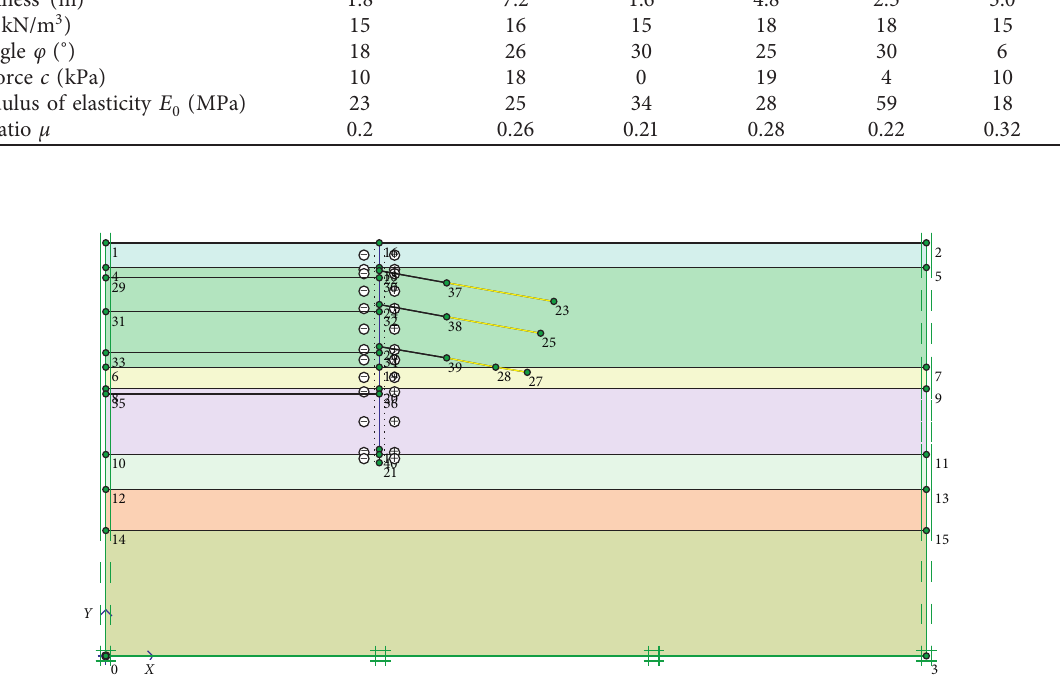
Figure 6: Computational geometric model.